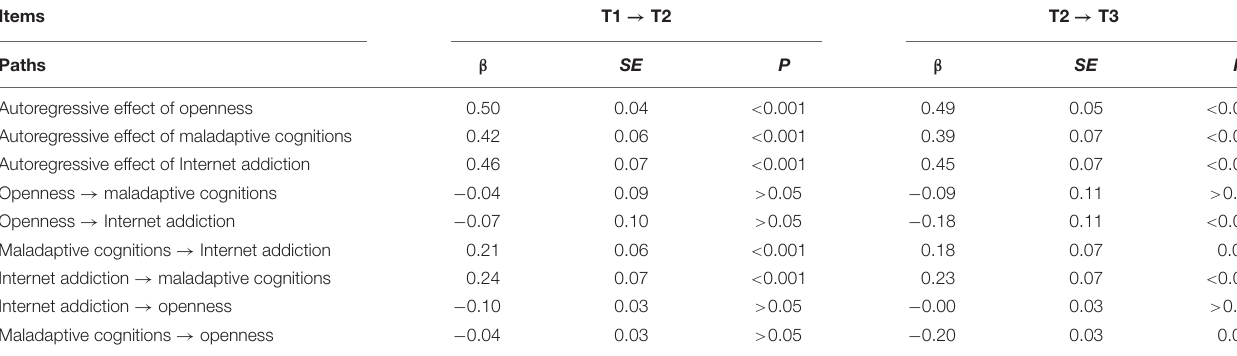
TABLE 8 | Regression coefficients of cross-lagged associations among openness, maladaptive cognitions, and Internet addiction within M5. Items T1 → T2 T2 → T3 Paths